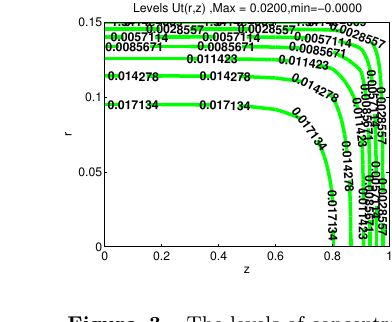
Figure 2. Averaging concentration u v depending on t 1 for r = 0